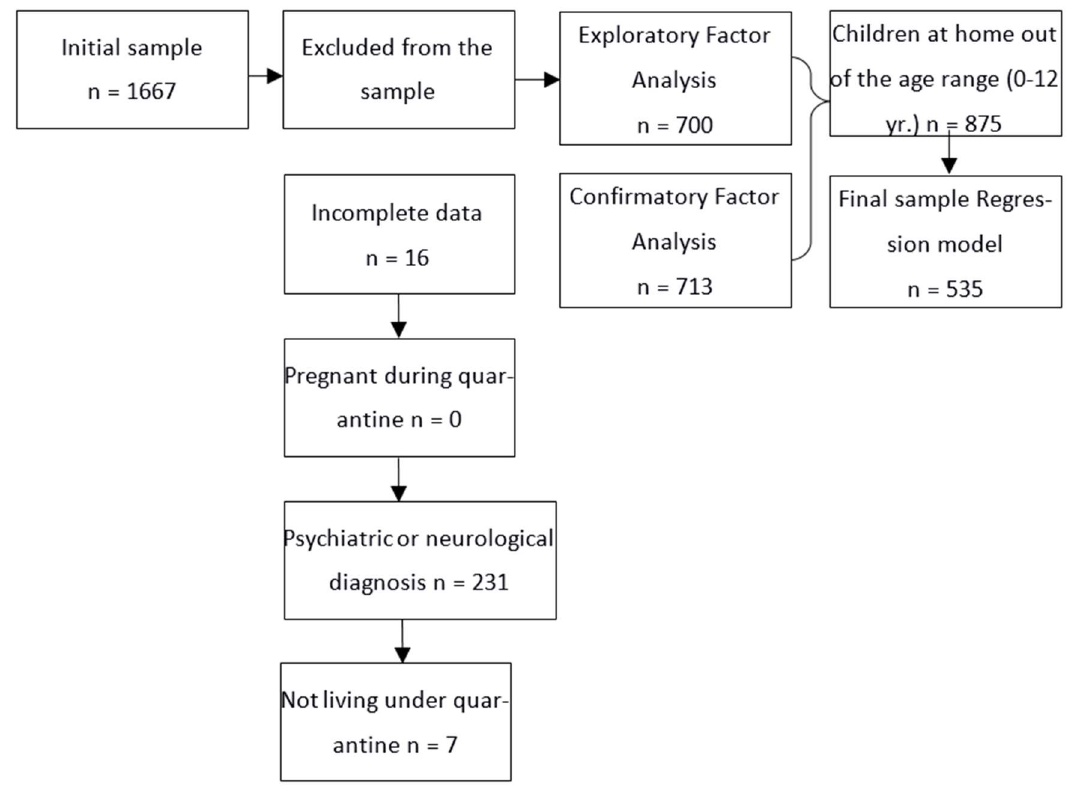
Figure 1. Steps for data analysis and exclusion of participants who did not meet the inclusion criteria. Table 1. Demographic characteristics of the sample.